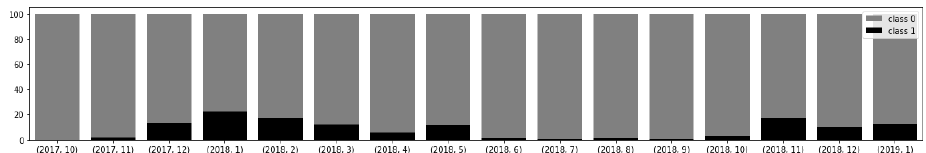
Figure 7. Percentage of samples belonging to each class by month in the recorded